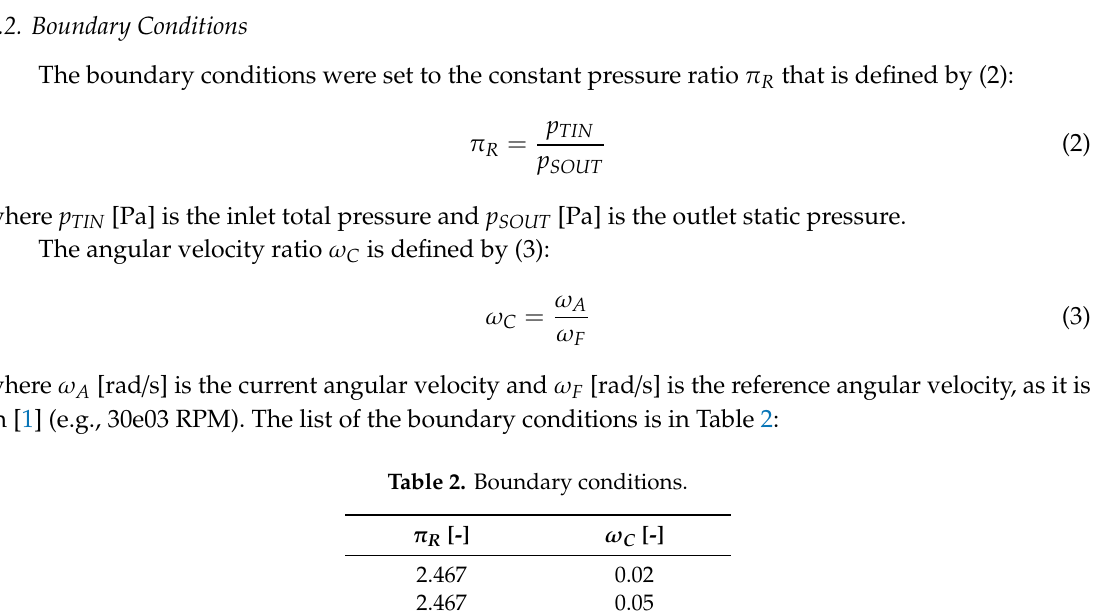
Figure 3. Calculation